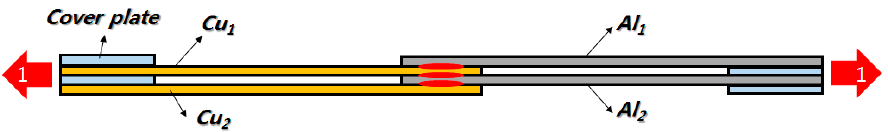
Figure 4. Procedure of one-step shear strength test for multi-lap joint welding.